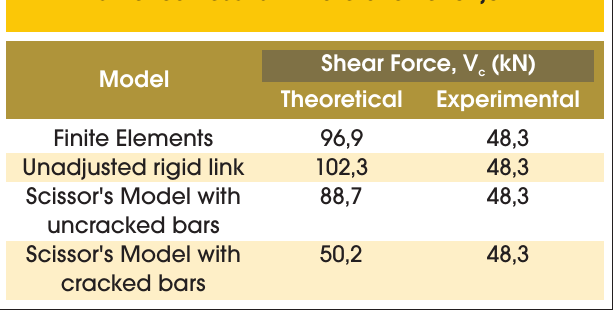
Figure 20 – Experimental setup for L-type joint [15]